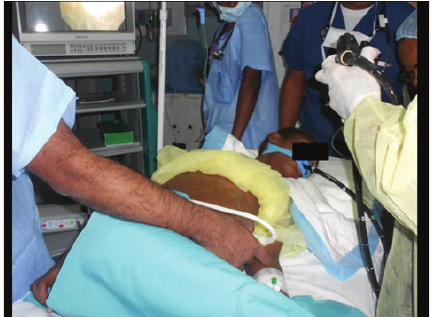
Figure 2: Gastroscope advanced into stomach to identify the area of bulging at the posterior gastric wall. Simultaneous transabdominal ultrasound being performed to guide the endoscopist to the ideal area for